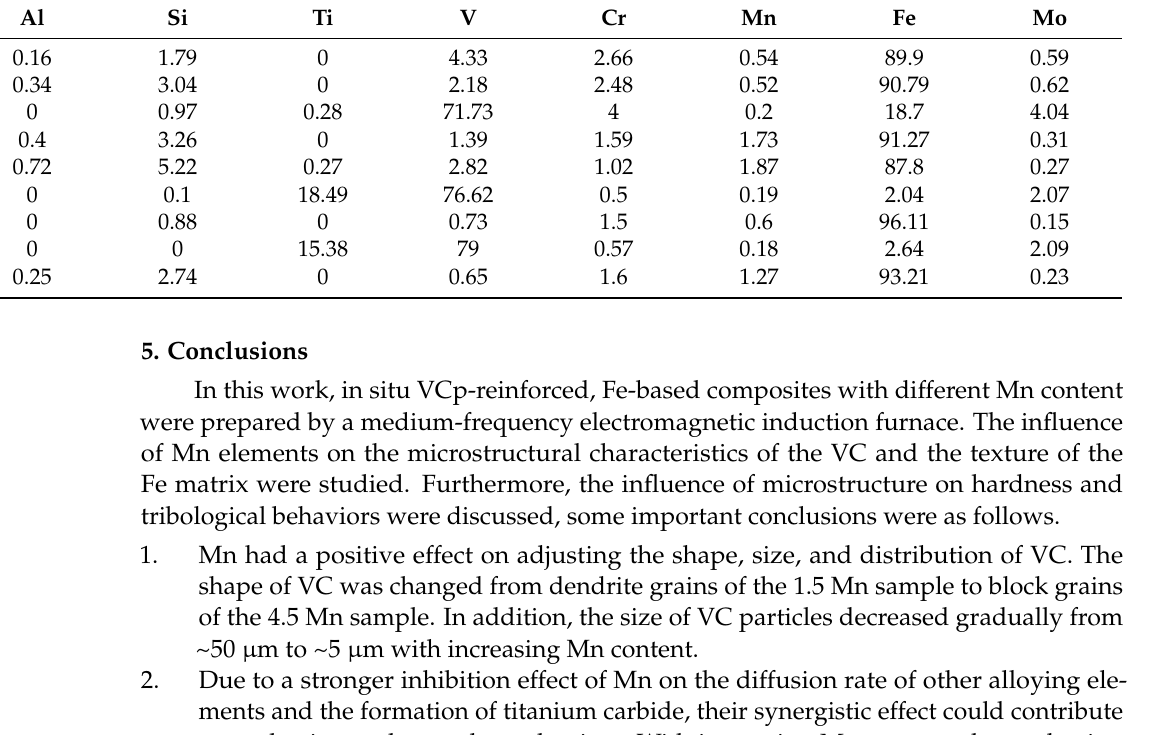
Figure 11. SEM images of wear tracks for three samples. ( a1 – a3 ) 1.5 Mn; ( b1 – b3 ) 3.0 Mn; ( c1 – c3 ) 4.5 Mn. Table 2. The corresponding atomic ratio of 1#~9# in Figure 11. Atomic Ratio